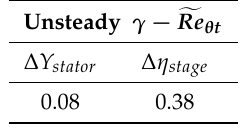
Table 2. “Snaked” blade benefits in a linear stage environment.